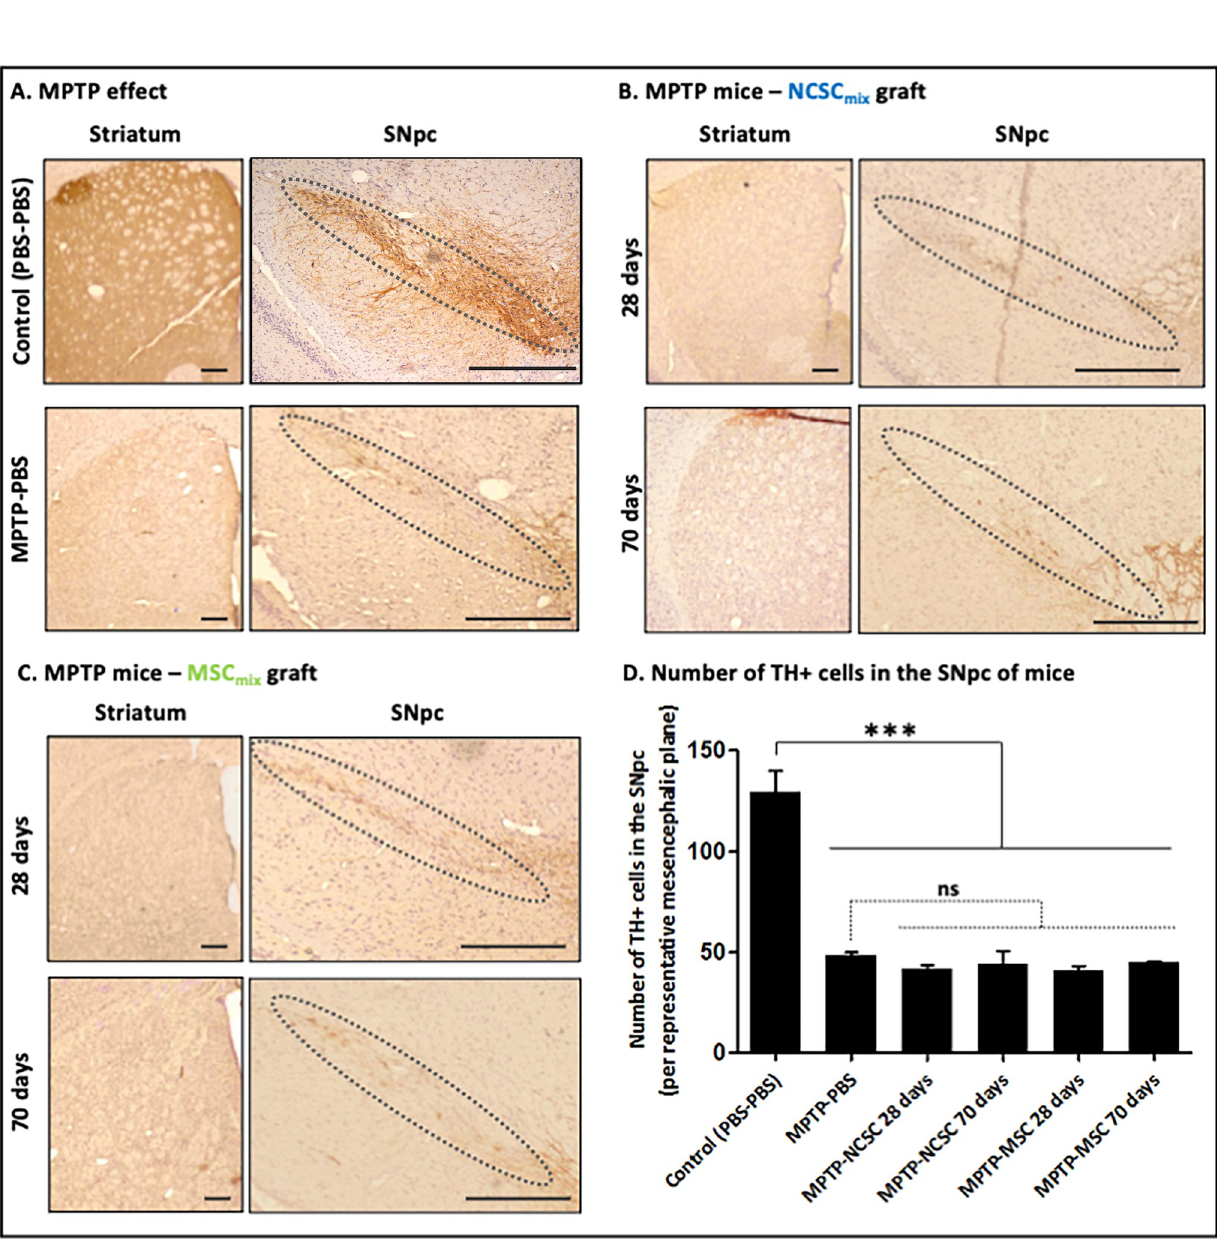
Fig 5. Evaluation of NCSCmix and MSCmix graft consequences on the number of host TH-positive neurons in MPTP-induced dopaminergic lesions. A. Effect of MPTP on the integrity of dopaminergic nigro-striatal pathway (at 28 days post-MPTP treatment). B. NCSC mix graft in MPTP-treated mice. No increase in TH-positive ( brown ) striatal dopaminergic fibers and TH-positive cell bodies in the SNpc is observed, at 28 days as well as 70 days post- NCSC mix transplantation. C. The same observations were carried out after MSC mix transplantation. D. Number of TH-positive cell bodies in the SNpc of MPTP-treated mice that were transplanted with NCSC mix /MSC mix (p > 0,05; Kruskall-Wallis ANOVA). Scale bars = 250 μ m.